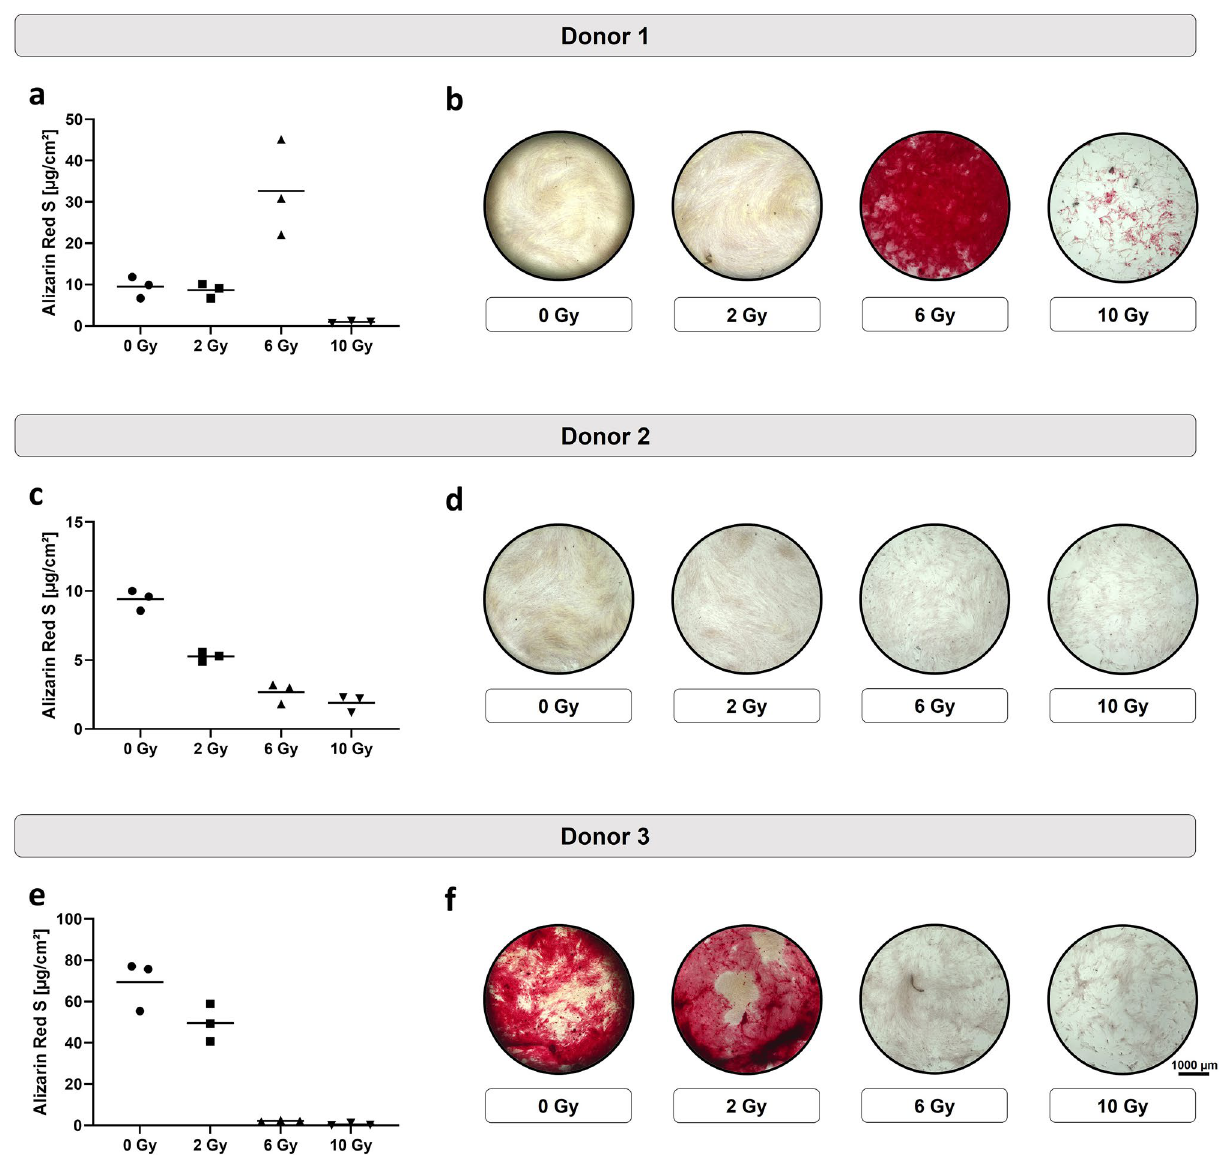
Figure 2. Mineralization of irradiated JHOBs. JHOBs were treated with different radiation doses and the level of mineralization was quantitatively ( a , c , e ) and qualitatively ( b , d , f ) assessed after 28 days of cultivation by Alizarin Red S staining. n = 3 biological replicates for each